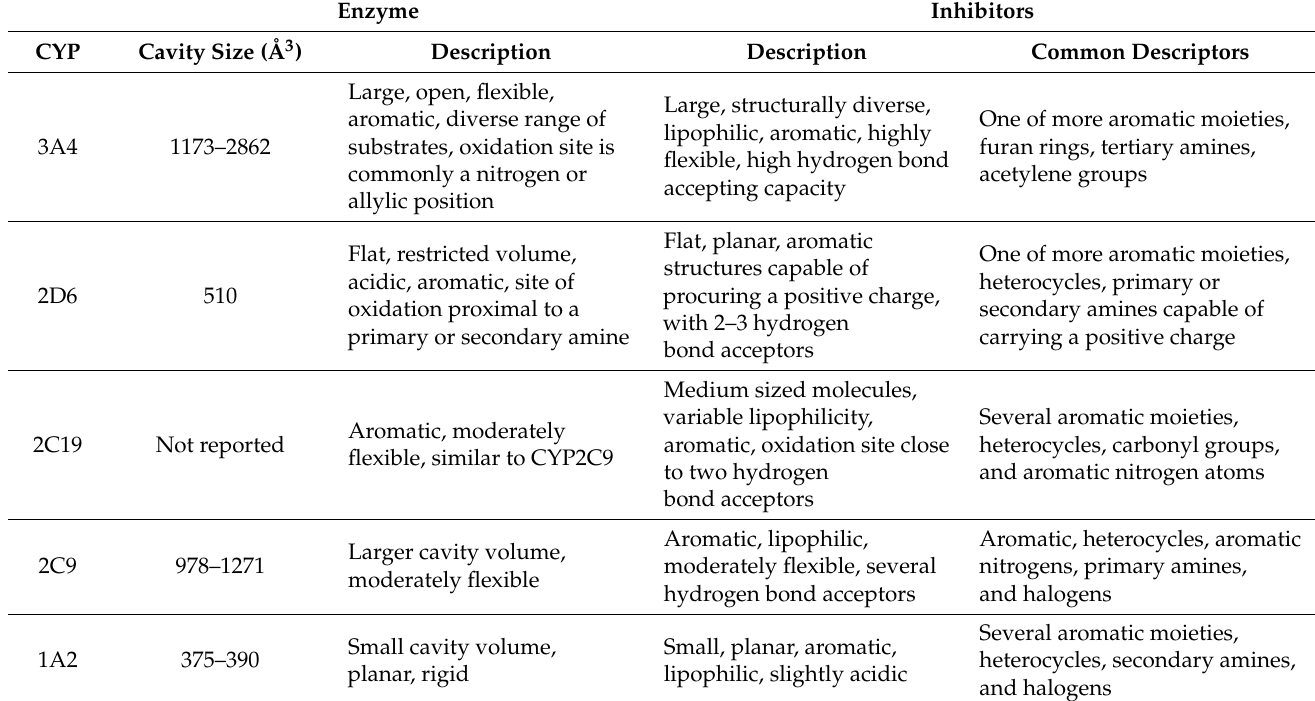
Table 1. Key characteristics of major cytochrome p450 enzymes and their